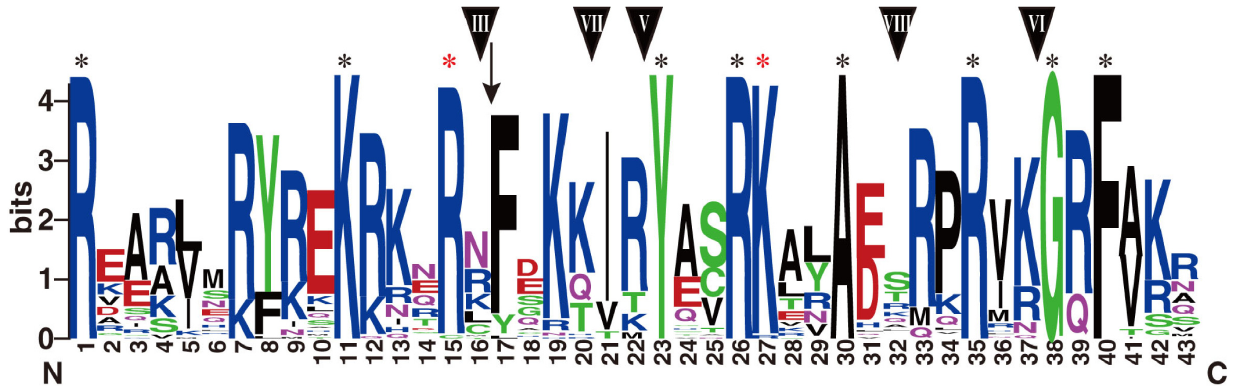
Fig 3. WebLogo representation of the conserved CCT domain. Black asterisks indicate identical residues in all CCT domains, and red asterisks indicate identical residues in most CCT domains. The black arrow indicates the residue insertion of PL before L17 in TaCMF7. Triangles with numbers representing the corresponding phylogenetic classification groups suggest the splitting site of the